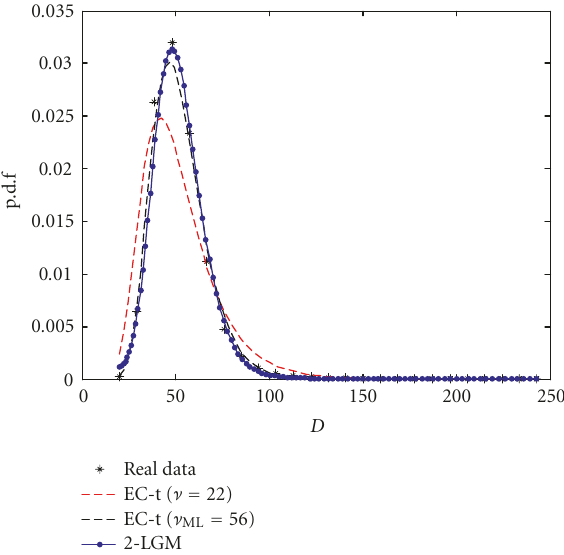
Figure 4: Class no.1 (grass) : p.d.f.’s for the real data and for three theoretical models.